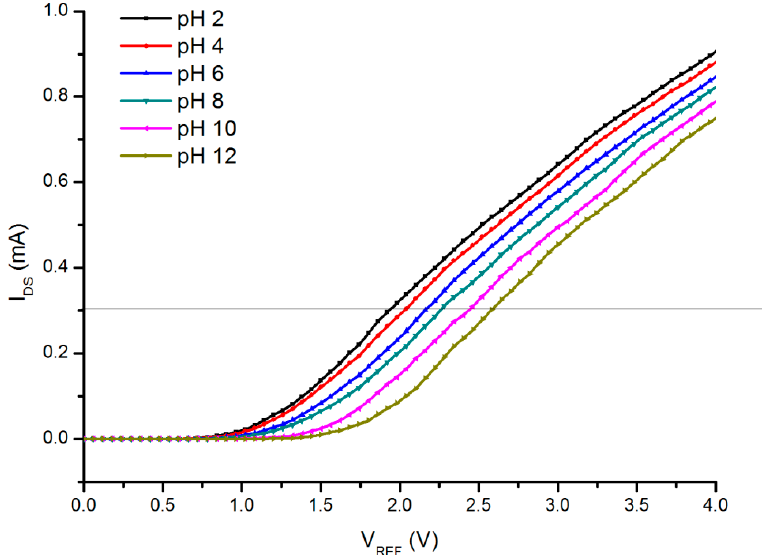
Figure 5. The I DS – V REF for the prepared PSi EGFET in the linear region for different pH buffer solutions (pH = 2 to 12). The V DS was kept constant at 300 mV. solutions (pH = 2 to 12). The V DS was kept constant at 300